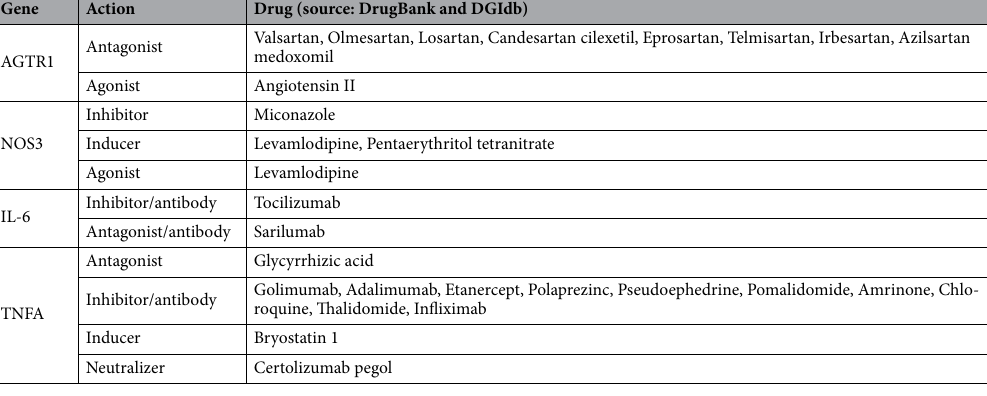
Table 3. List of approved drugs that target AGRT1, IL-6, NOS3 and TNFA.